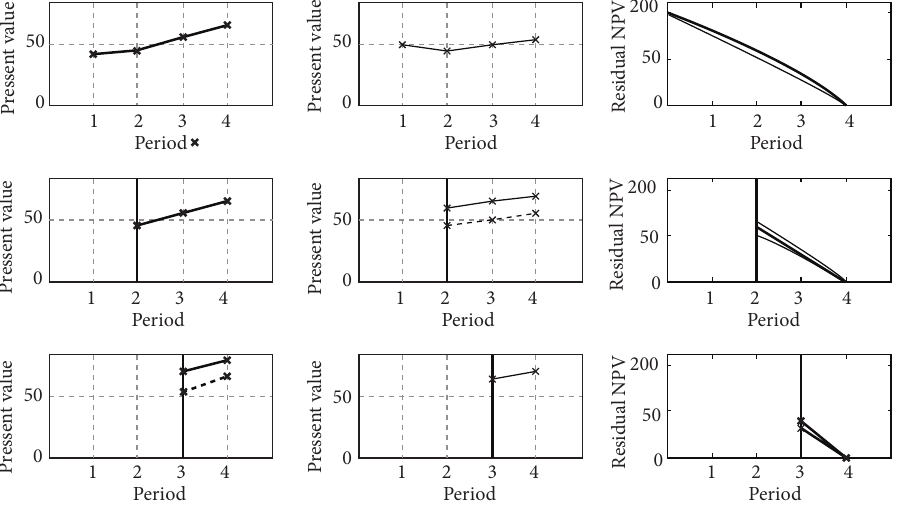
The results in table 3 refer to the z-tree experiment game of figure 6. The average deviation ratio of the OOCS-rule is: 0.1262=12.62%. The average deviation ratio of the ADMCS-rule is: 0.8081 = 80.81 %